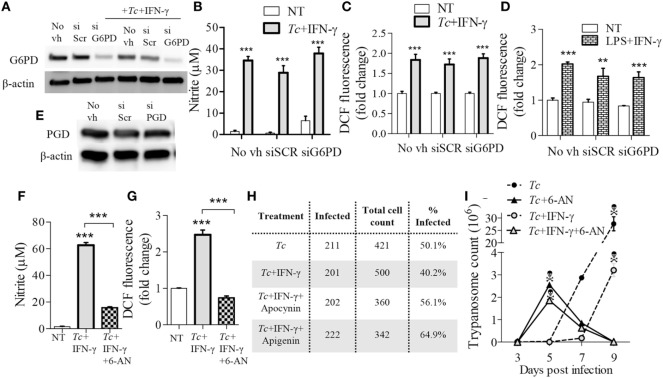
Reliance on pentose phosphate shunt by Trypanosoma cruzi (Tc) + IFN-γ-activated macrophages. (A–E) RAW 264.7 macrophages were transfected with glucose-6-phosphate dehydrogenase (G6PD), 6-Phosphogluconate dehydrogenase (PGD), or scrambled (SCR) siRNAs, or treated with media in absence of transfection vehicle (No vh) for 24 h. Transfected (and control) macrophages were then incubated for 18 h with Tc ± IFN-γ or lipopolysaccharide (LPS) + IFN-γ for 18 h. Shown are G6PD (A) and PGD (E) protein levels (β-actin, loading control) by western blotting, and nitric oxide (NO) release (B), and intracellular reactive oxygen species (ROS) levels (C,D) by Griess assay and DCF fluorescence, respectively. (F–I) RAW 264.7 macrophages were incubated for 18 h with Tc in the presence or absence of IFN-γ (50 ng/mL), 6-aminonicotinamide (6-AN; 100 µM, inhibits PGD), apocynin (1 mM), or apigenin (100 µM). The NO release (F) and intracellular ROS (G) were measured as above. Macrophages were fixed at 18 h post-infection (pi), stained with Giemsa-Wright solution, and then ≥200 Tc-bearing macrophages were counted. The percentages of infected cells are reported in panel H. Trypanosome release from infected (±treatment) macrophages was quantified at 3, 5, 7, and 9 days pi (I). Data are presented as the mean ± SEM of ≥3 biological replicates. ANOVATukey **p < 0.01 and ***p < 0.001 in comparison to no-treatment controls unless indicated by a line over compared groups.